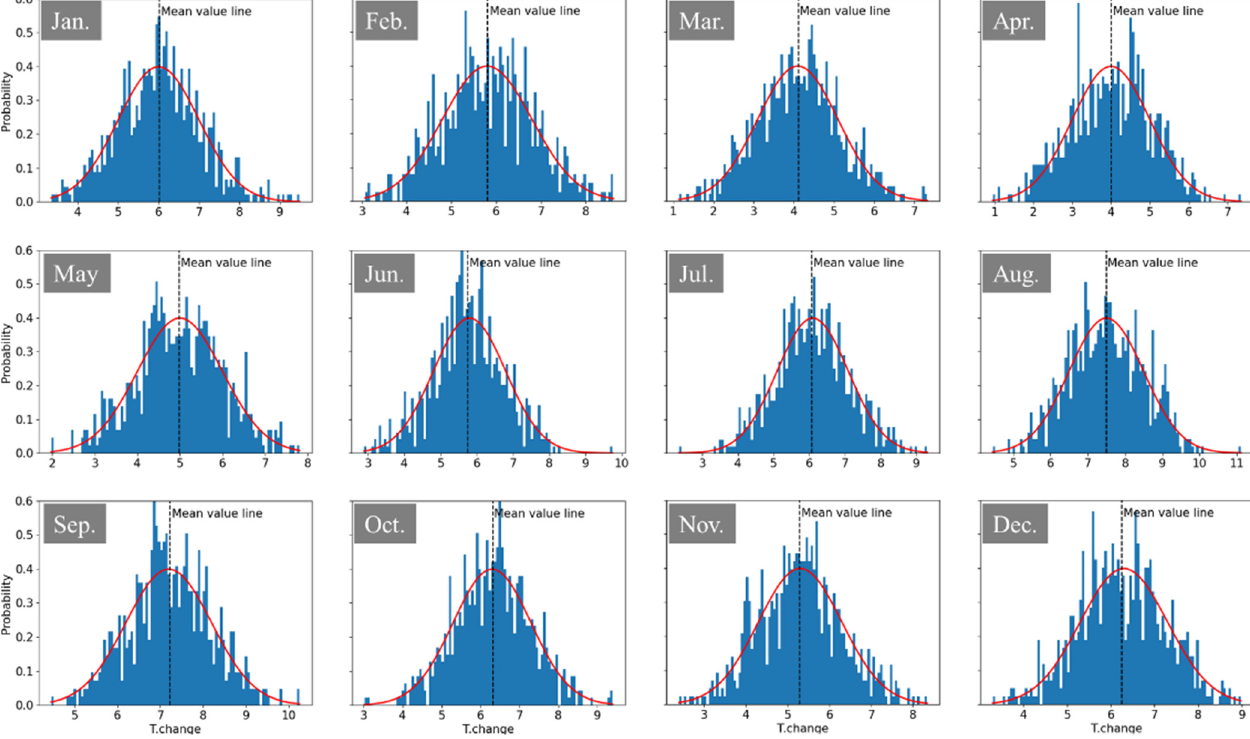
Figure 3. Monthly distributions of hourly temperature changes for scenario the 2080s in 4A New York, NY.